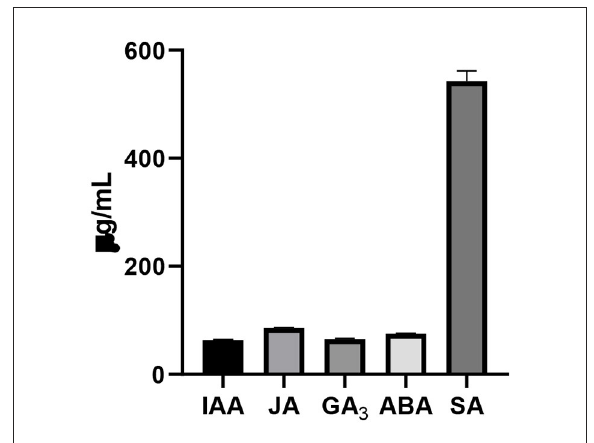
FIGURE4 Determination of different phytohormones including IAA, JA, GA3, ABA, and SA in the culture filtrate of the isolated endophytic F. oxysproum GW grown in Capek medium for 5 days. Bars show the mean of three replicates with standard